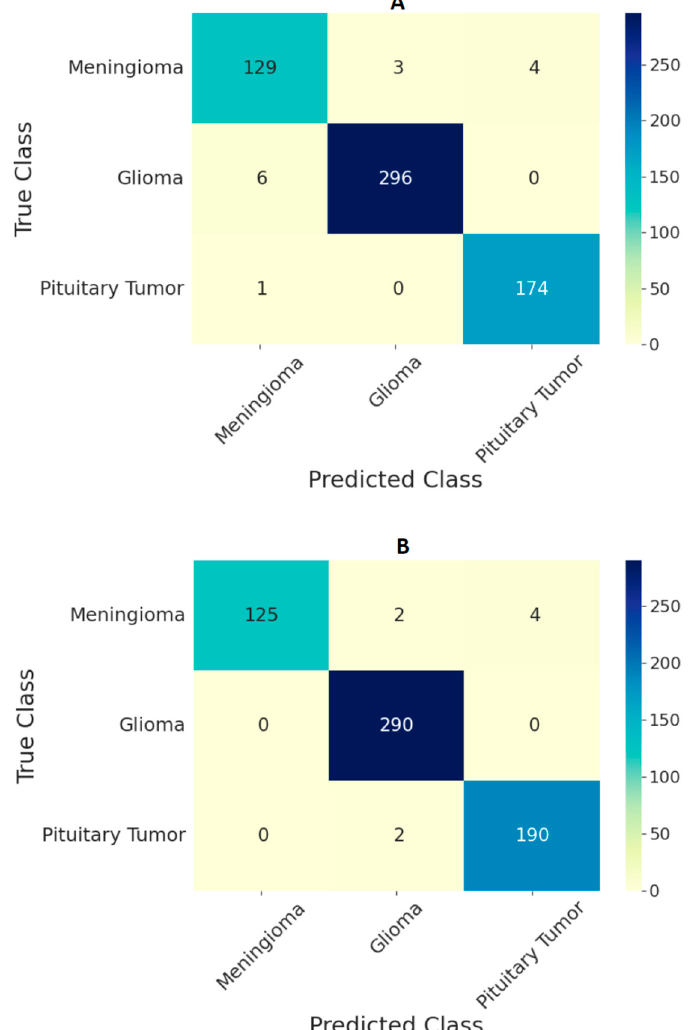
Figure 6. Confusion matrix for classification of three types of tumors on the test set using an ensemble of ViT models B/16, B/32, L/16, and L/32 at ( A ) 224 × 224 resolution and ( B ) 384 × 384 resolution.